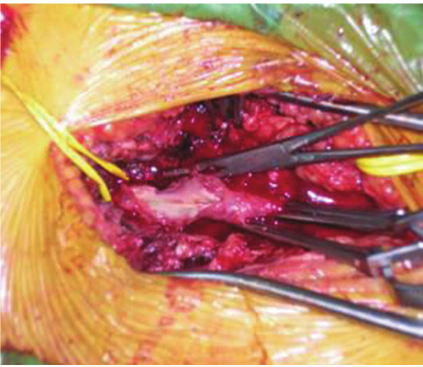
Figure 4: Destruction of anterior wall of common femoral artery due to infection process.